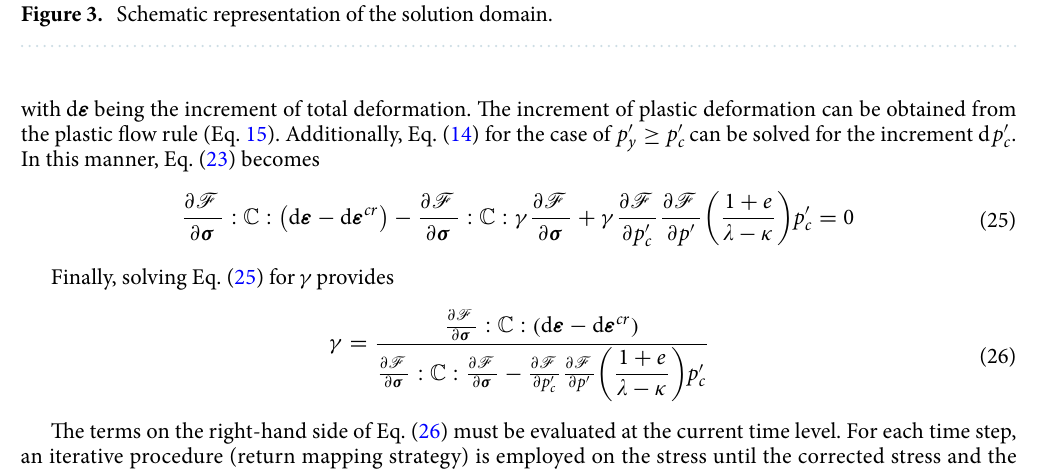
Figure 3. Schematic representation of the solution